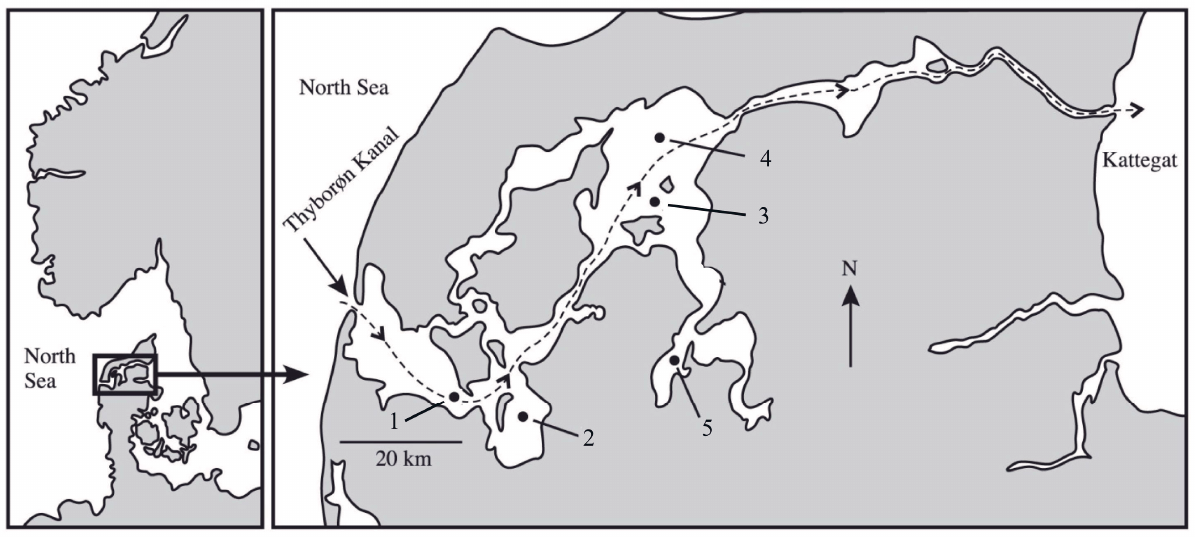
Figure 1. Locations of sampling sites in Limfjorden (Denmark) where ctenophores were collected on cruises during 2013. 1 = Nissum Bredning (56°34 ′ 25.80 ″ N, 08°29 ′ 41.40 ″ E), 2 = Venø Bugt (56°31 ′ 23.40 ″ N, 08°40 ′ 27.60 ″ E), 3 = Livø Bredning (56°51 ′ 57.60 ″ N, 09°02 ′ 57.00 ″ E), 4 = Løgstør Bredning (56°57 ′ 09.00 ″ N, 09°03 ′ 27.60 ″ E), 5 = Skive Fjord (56°37 ′ 15.00 ″ N, 09°05 ′ 33.00 ″ E). The path of water exchange between the North Sea in west and Kattegat in the east is indicated by a broken line.